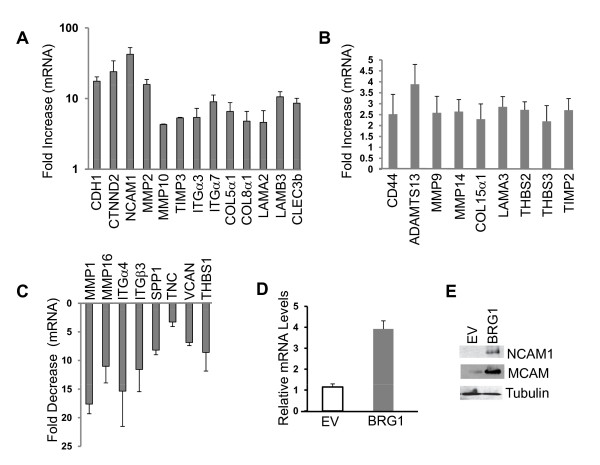
BRG1 modulates the expression of extracellular matrix and adhesion molecule expression in SK-MEL5 cells. The expression of extracellular and adhesion molecule related genes was profiled in control SK-MEL5 (empty vector) and BRG1 reconstituted SK-MEL5 cells using a focused qPCR array. The expression level of each gene was normalized to a control value obtained by averaging the expression of four housekeeping genes. The average of three to four independent experiments is shown. All changes in gene expression are statistically significant as determined by the student's t test (p value equal to or less than 0.05). A. Expression of genes that are activated greater than four-fold by BRG1. B. Expression of genes that are activated greater than two fold by BRG1. C. Expression of genes that are down-regulated by BRG1. D. MCAM expression was evaluated separately from the qPCR array using gene specific primers. Normalization of mRNA levels was to GAPDH. E. Detection of NCAM1 and MCAM protein expression by Western blotting. Tubulin is a loading control.